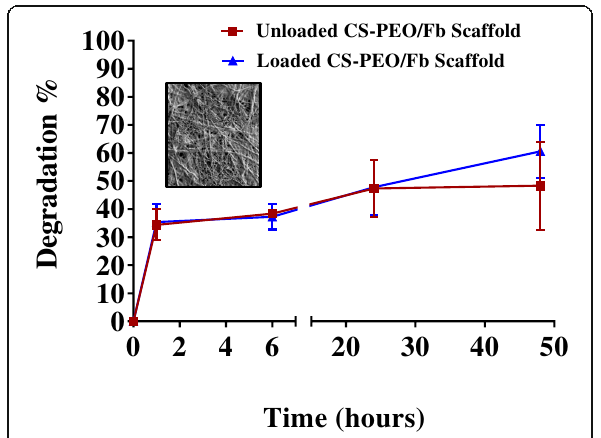
Fig. 10 Degradation of electrospun unloaded CS-PEO/Fb scaffolds and PDGF-loaded (8 μ g/mL) CS-PEO/Fb scaffolds. Insert: FESEM